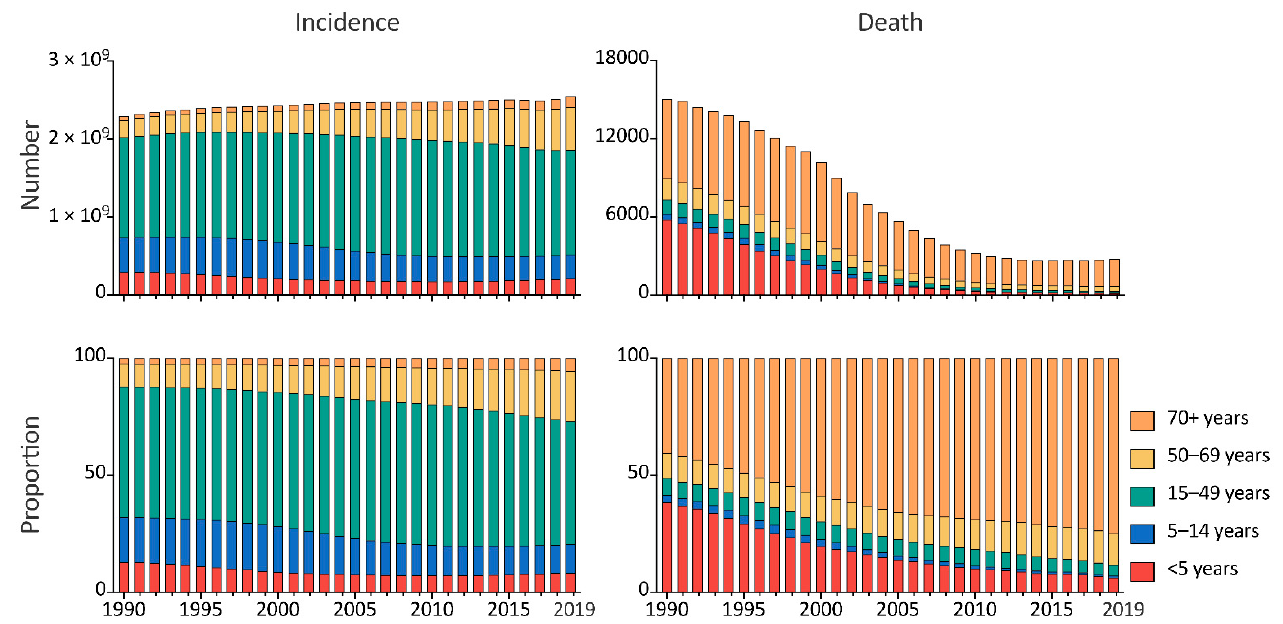
Figure 5. The number and proportions of upper respiratory infection cases and deaths by age group, from 1990 to 2019, in China.